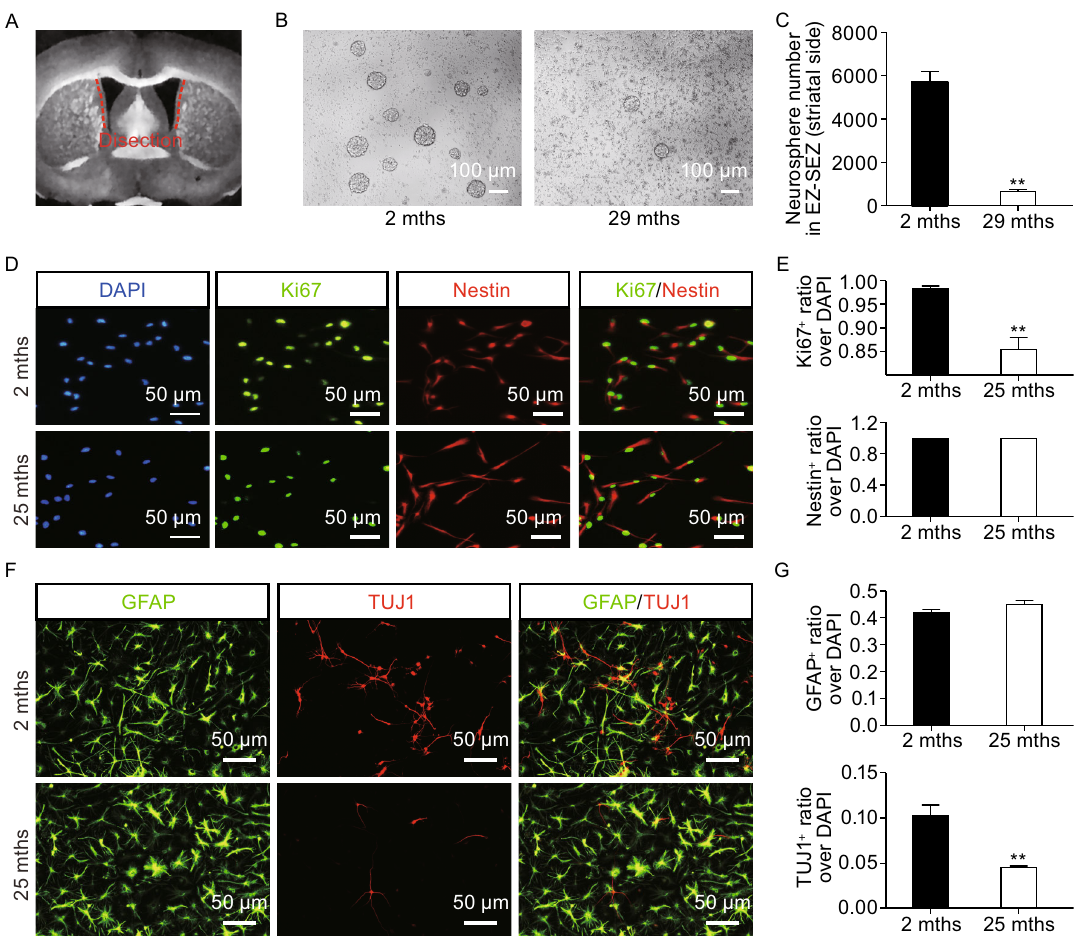
Figure 1. Decreased proliferation and neurogenic potential of cultured NSC/NPCs derived from aged mouse SEZ/SVZ. (A) Schematic showing SVZ dissection site. (B) Neurospheres clonally derived from NSC/NPCs from young (2 mths) and old (29 mths) mouse SEZ/SVZs. (C) Quanti fi cation of neurospheres in (B) ( n = 3). (D) Immuno fl uorescence staining of Ki67 and Nestin in cultured NSC/NPCs from young (2 mths) and old (25 mths) mouse SEZ/SVZ. (E) Quanti fi cation of (D). (F) Representative fi elds of GFAP and Tuj1 immuno fl uorescence staining of cultured NSC/NPCs from young (2 mths) and old (25 mths) mice, after 7 days of spontaneous differentiation. (G) Quanti fi cation of (F). (** P < 0.01, n